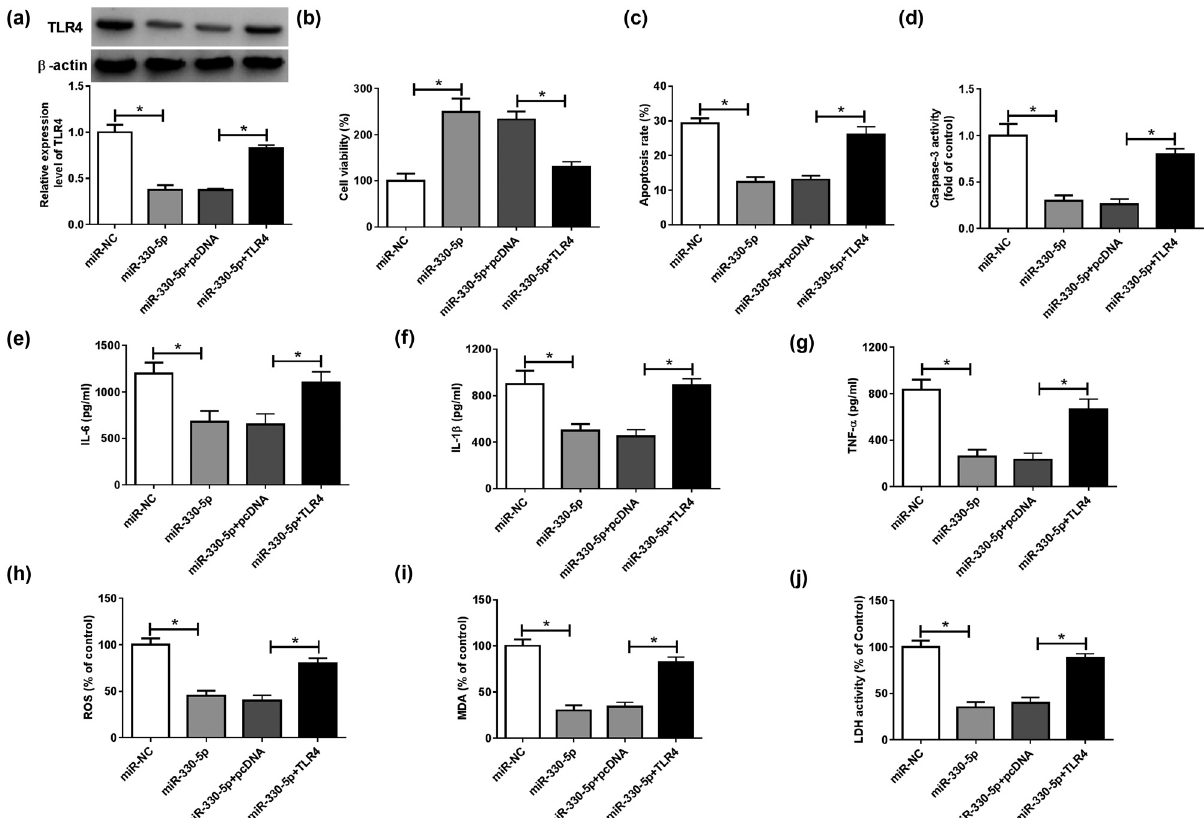
Figure 6: E ff ects of miR - 330 - 5p mimic and TLR4 overexpression on ox - LDL - induced HUVECs injury. HUVECs were transfected with miR - NC, miR - 330 - 5p, miR - 330 - 5p + pcDNA, or miR - 330 - 5p + TLR4, followed by treatment with ox - LDL. ( a ) The protein level of TLR4 was determined using WB analysis. ( b ) The viability of HUVECs was detected via CCK8 assay. ( c ) The apoptosis of HUVECs was measured using fl ow cytometry. ( d ) Caspase - 3 Activity Assay Kit was used to determine the activity of caspase - 3. ( e – g ) The IL - 6, IL - 1 β , and TNF - α ELISA Assay